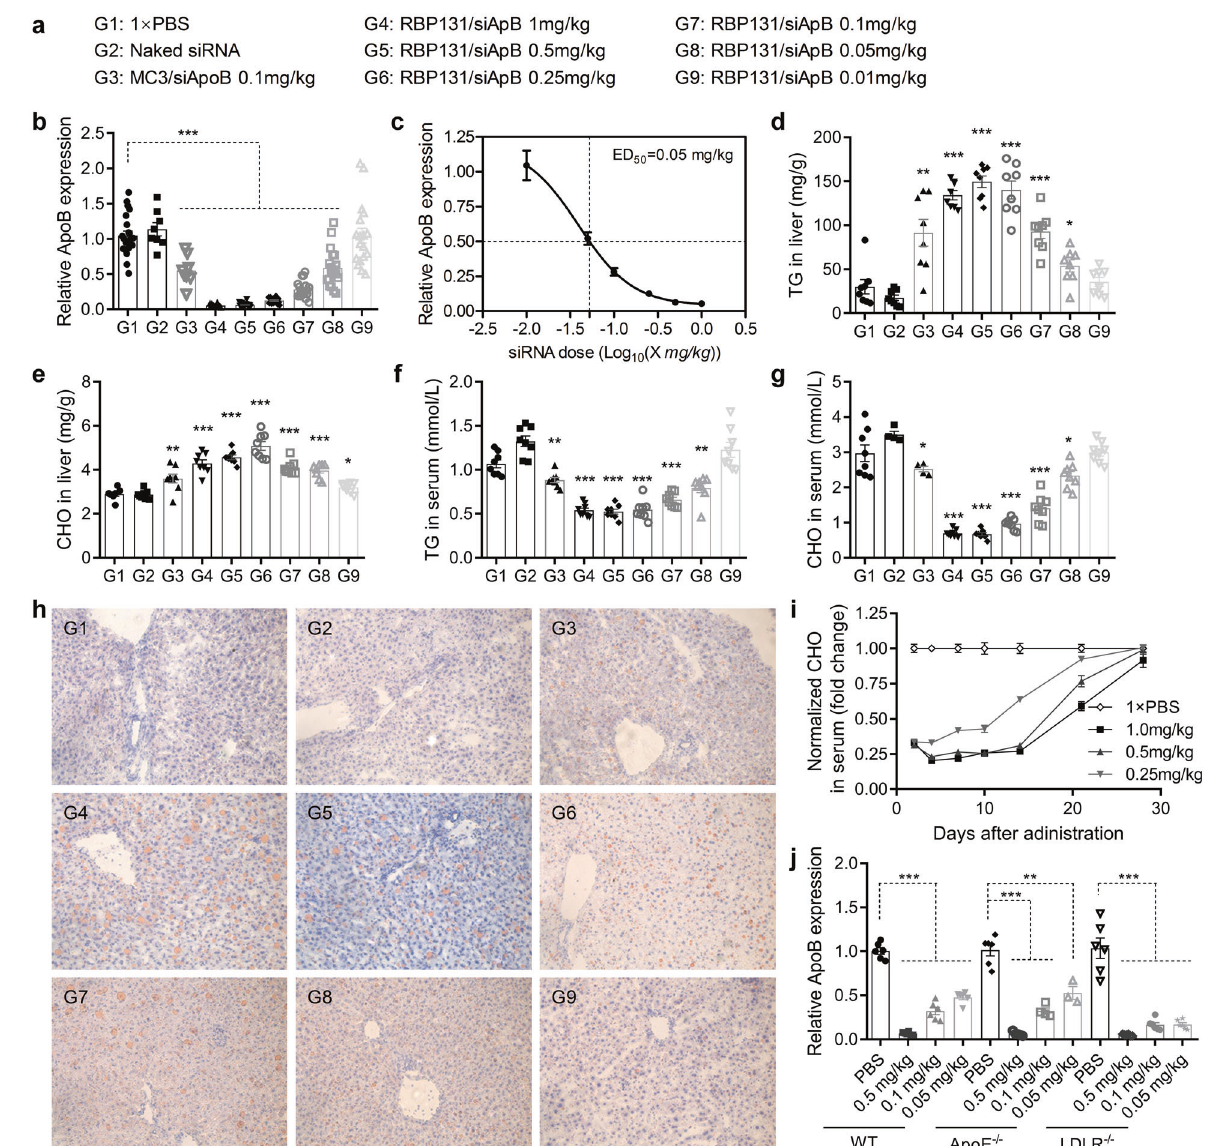
Fig. 2 In vivo silencing performances and mechanism exploration of RBP131/siApoB nanoparticle. a Grouping information. b Relative apoB mRNA expression of the mice received various doses of the formulations. siApoB encapsulated with Dlin-MC3-DMA was included as a positive control (PosCtl). c ApoB mRNA expression level fi tted with the function of ‘ Y = Bottom + (Top-Bottom) / (1 + 10^((LogIC50-X) × HillSlope)) ’ , with which the ED 50 was calculated. d , e Total triglyceride (TG) ( d ) and total cholesterol (CHO) ( e ) levels in the liver. f , g TG ( f ) and CHO ( g ) levels in the serum. h Oil Red O staining for the liver sections. All images were enlarged 200 times with a microscope. i Longevity cholesterol reduction of mice receiving a single dose of RBP131/siApoB formulation. j Gene expression of ApoB in wild type C57BL/6 mice, apoE knockout mice (ApoE − / − ), and LDLR knockout mice (LDLR − / − ). Data were shown with the mean ± SEM. * P < 0.05, ** P < 0.01, *** P < 0.001, vs the PBS